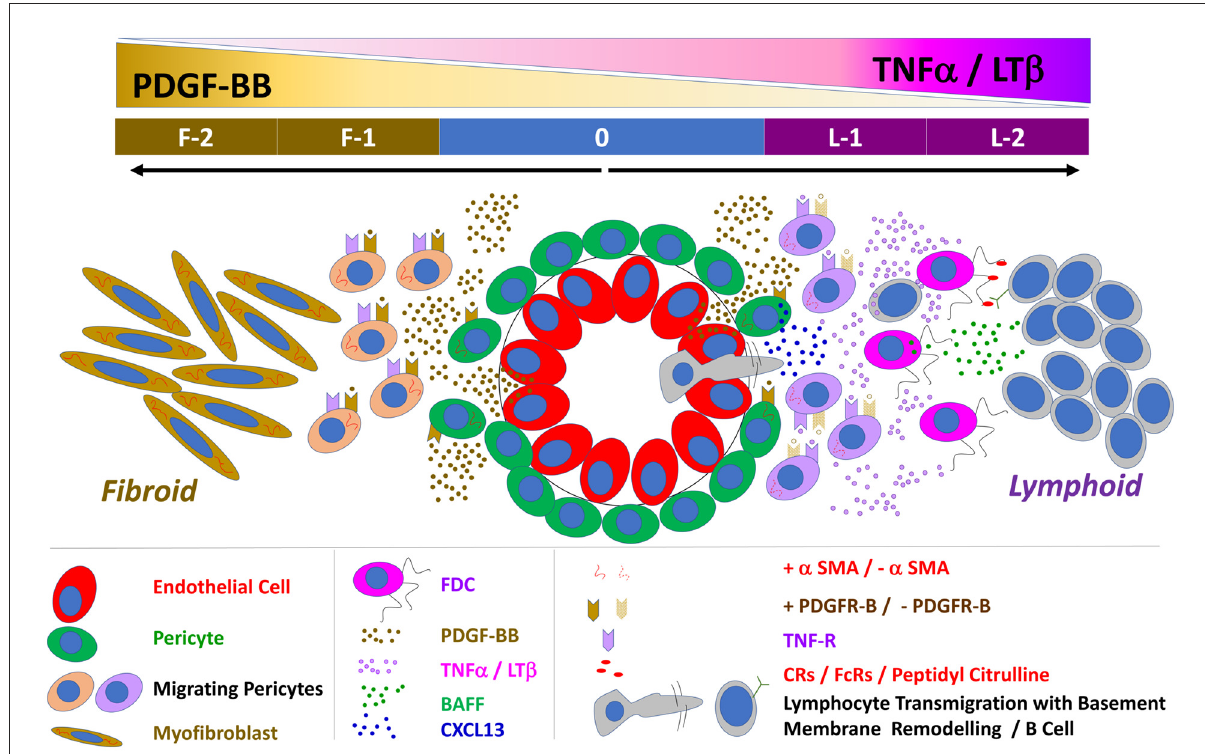
FIGURE10 Schematic representation of the proposed interaction between PDGF-BB and TNF- α /LT- β in FDC development and induction of lymphoid vs. fibroid RA pathotypes: 0 = Neo-angiogenesis in the inflamed synovium is regulated by the reciprocal activation of the endothelial cells and their covering pericytes. PDGF-BB is mainly produced by endothelial cells and activates the PDGFR- β + pericytes whereas pericytes are the main source of VEGF that stimulates endothelial growth and sprouting. PDGF-BB induces α SMA expression, pericyte migration, TNF-R expression, and the FDC marker CNA.42 on the ubiquitously available perivascular FDC precursors. F-1 = In the absence of TNF- α /LT- β , the TNF-R is not engaged, and the effect of PDGF-BB is maintained leading to extensive generation of α SMA + myofibroblasts. F-2 = Myofibroblasts further divide, migrate and invade bones and cartilage, the vasculature degenerates due to loss of the stimulatory effect of the pericyte-derived VEGF and a fibroid pathotype of RA synovitis is instituted. L-1 = Pericyte activation by PDGF-BB induces CXCL13 expression and dissociation from the vessel wall thus facilitating B cell influx which extensively remodel of the vascular basement membrane. In the presence of B cell derived TNF- α /LT- β , the TNF-R is engaged leading to (1) downregulation of PDGFR- β and α SMA expression (2) upregulation of the FDC maturation markers like the antigen retaining complement and Fc receptors and BAFF. L-2 = Synovial retention of the circulating auto ICs on the mature FDC reticula induces B cell activation, proliferation, and local autoantibody production, thus establishing a fully functional ectopic lymphoid-like